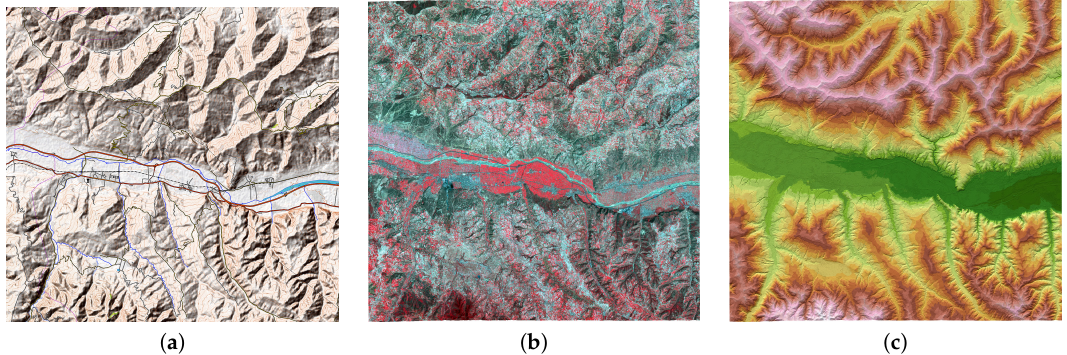
Figure 7. The test site Tian Shui (China): ( a ) topographic map (opentopomap.org (CC-BY-SA)), ( b ) CIR ortho-image and ( c ) relief shaded DSM. ( b , c ) were produced employing the proposed and implemented mapping